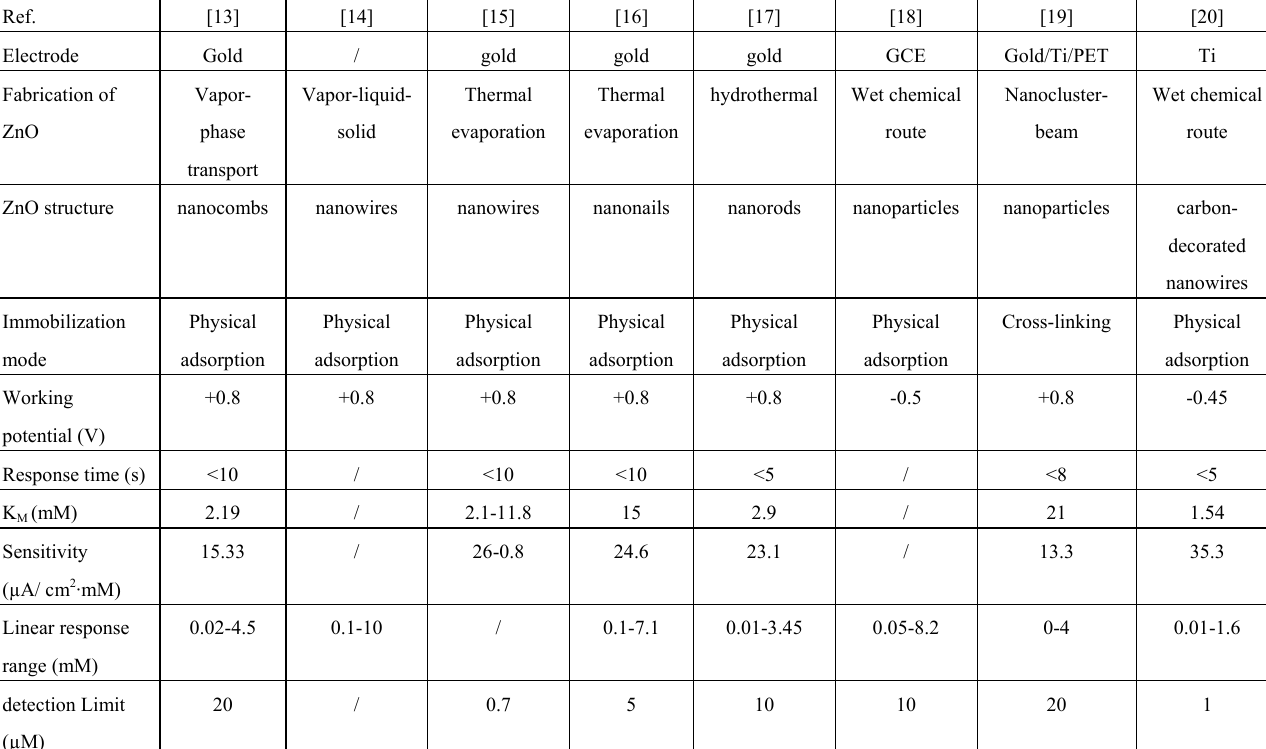
Table 1. ZnO-based electrochemical biosensors for glucose detection (GOD as enzyme) (GCE: glass carbon electrode; Gold/Ti/PET: Gold/Ti/ poly (ethyleneterephthalate); “/” in the table means the corresponding content is not